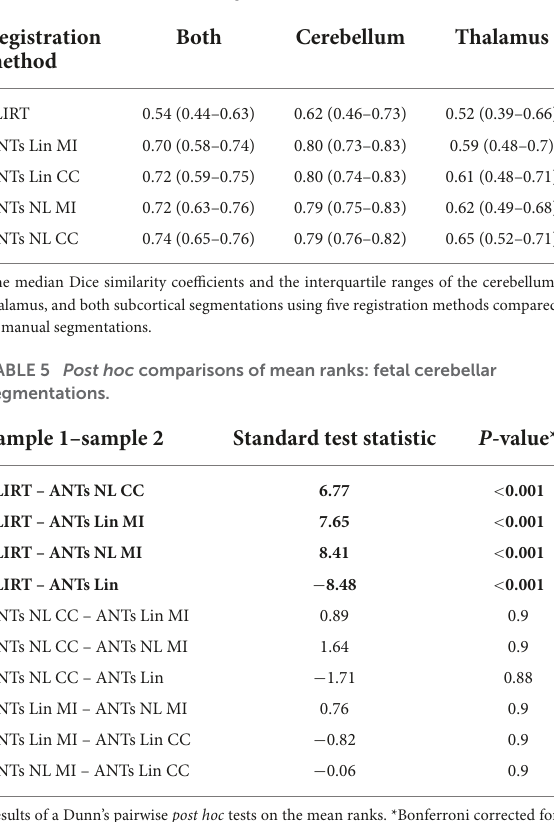
TABLE 4 Median Dice similarity coefficients.